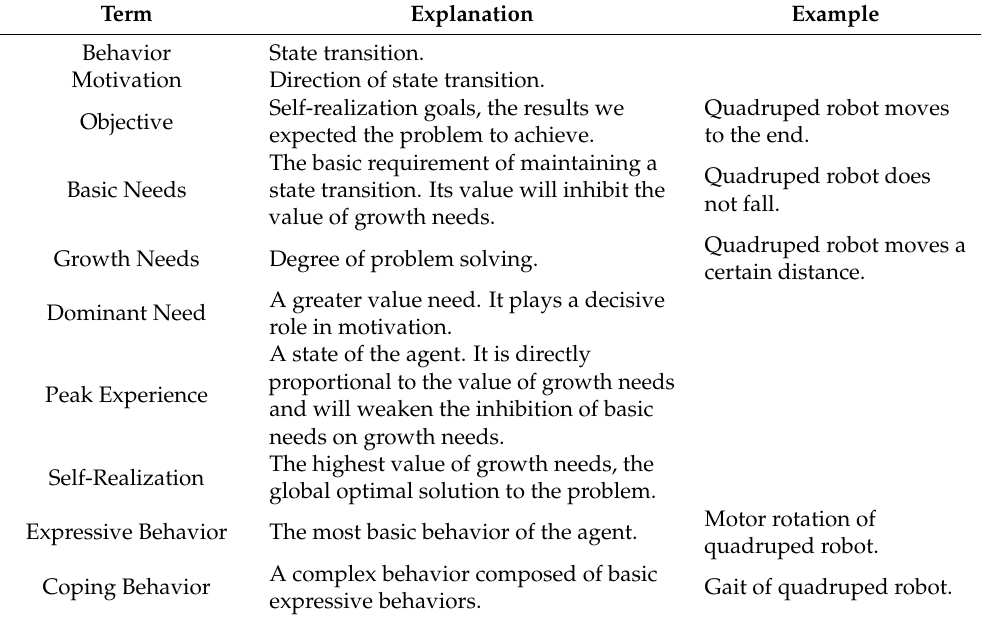
Table 1. Definition of the needs learning